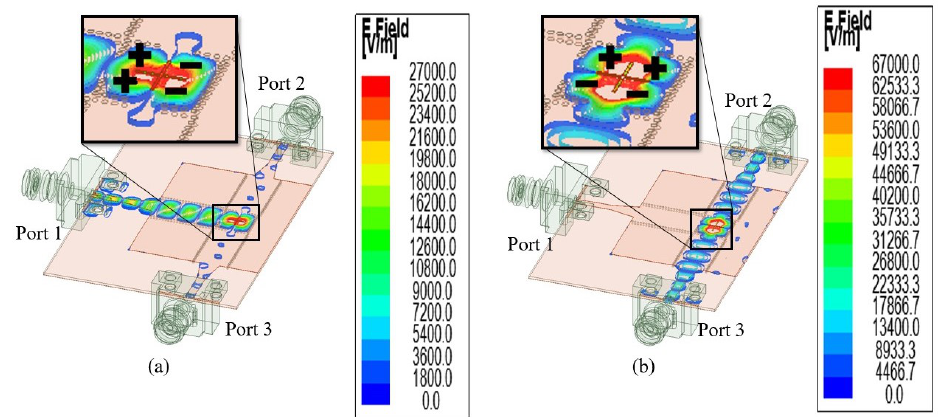
Figure 2. Modes (electric field) intensity for antenna at 28 GHz, ( a ) single-ended excitation from port 1, ( b ) differential excitation from port 2 and port 3 [red and blue show highest and lowest intensity,